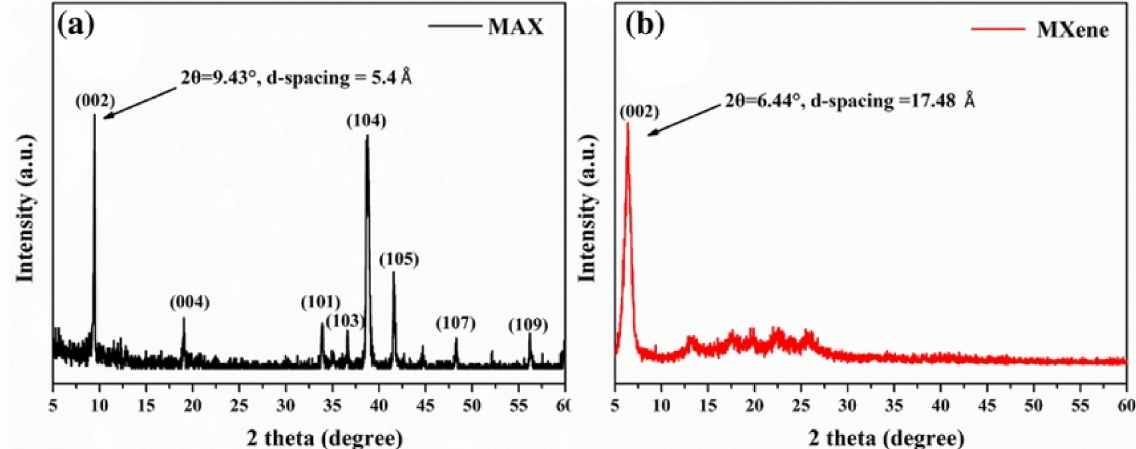
Figure 6. XRD data of ( a ) Ti 3 AlC 2 MAX phase and ( b ) Ti 3 C 2 T x MXene. It is clear that, except for the (0002) peaks, all other peaks in the MXene data almost vanished. Also, there is a downward shift of angle from 9.43 ◦ to 6.44 ◦ and a d-spacing increase from 5.4 Armstrong to 17.8 Armstrong. Reprinted with permission from ref [71] (Sheng et al., 2021). Copyright Springer US.